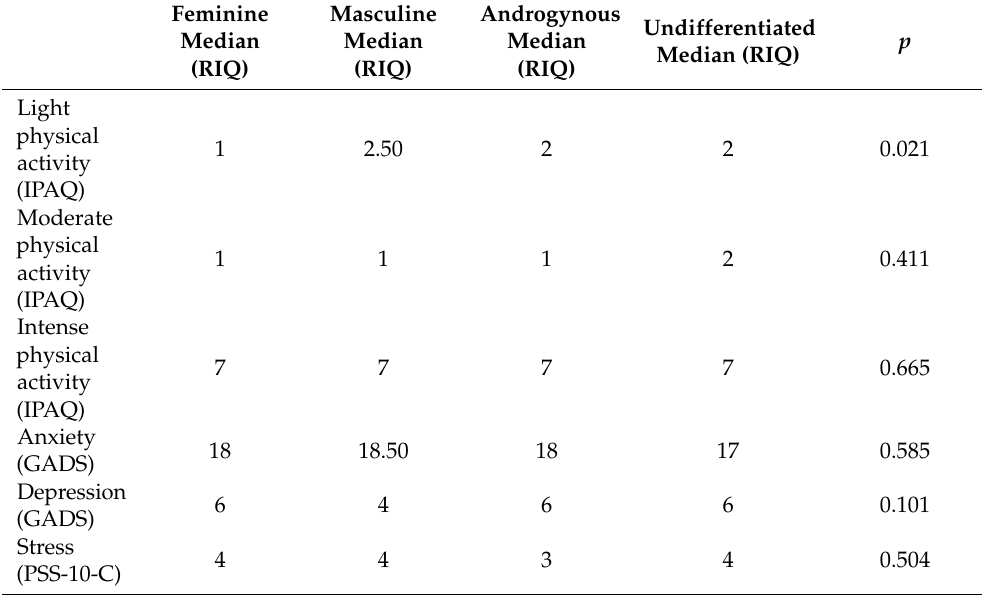
Table 6. Relation between gender role and health